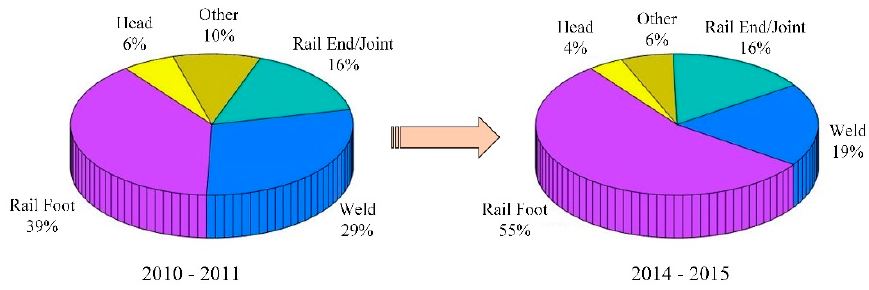
Figure 2. Distribution of the main locations of rail fractures in the UK railway network.